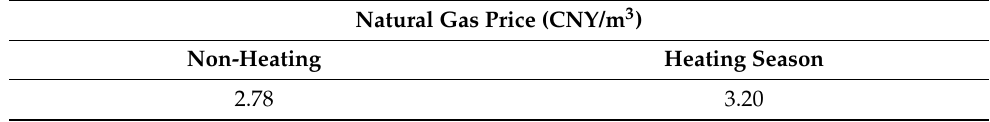
Table A8. Gas price of Xinxiang City, Henan Province.